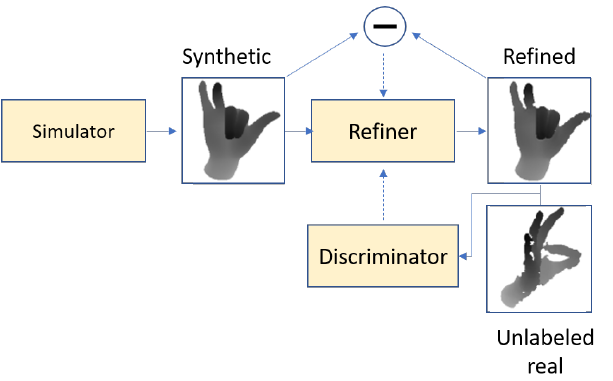
Figure 3. Overview of SimGAN; the self-regularization term minimizes the image difference between the synthetic and the refined images. Adapted from